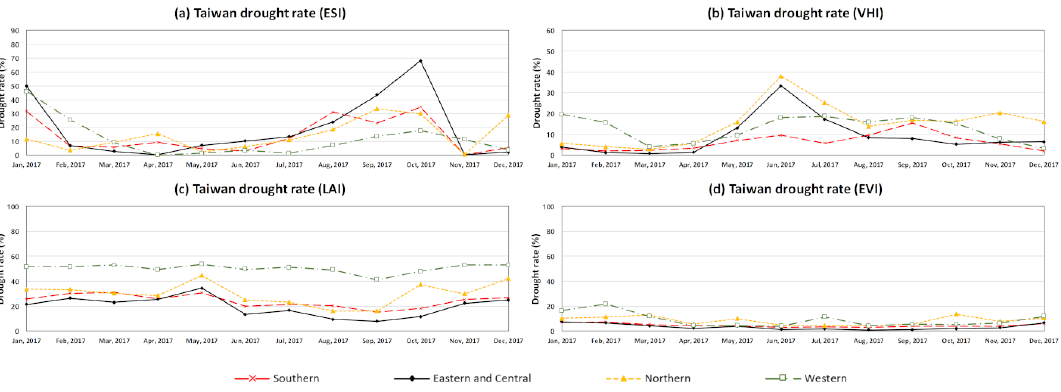
Figure 6. Temporal changes in drought area ratios of total area in each district as determined by the ( a ) ESI, ( b ) VHI, ( c ) LAI, and ( d ) EVI values for the four regions in Taiwan during the 2017 drought